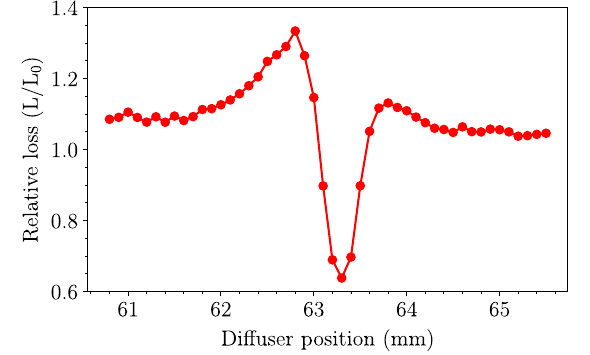
FIG. 18. Simulated (full 5D PTC ) relative total loss for a nonlocal diffuser 7 mm long, 400 μ m wide in